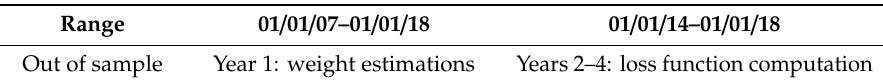
Table A1. Out-of-sample